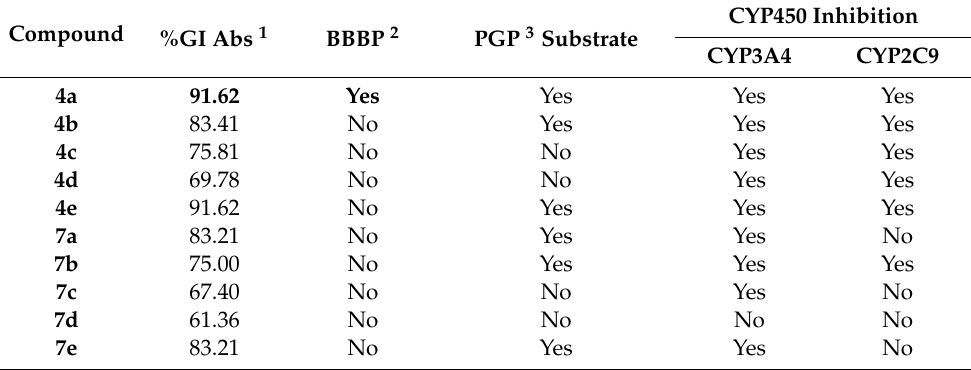
Table 5. Computationally predicted pharmacokinetic profile of compounds 4a – e and 7a – e .